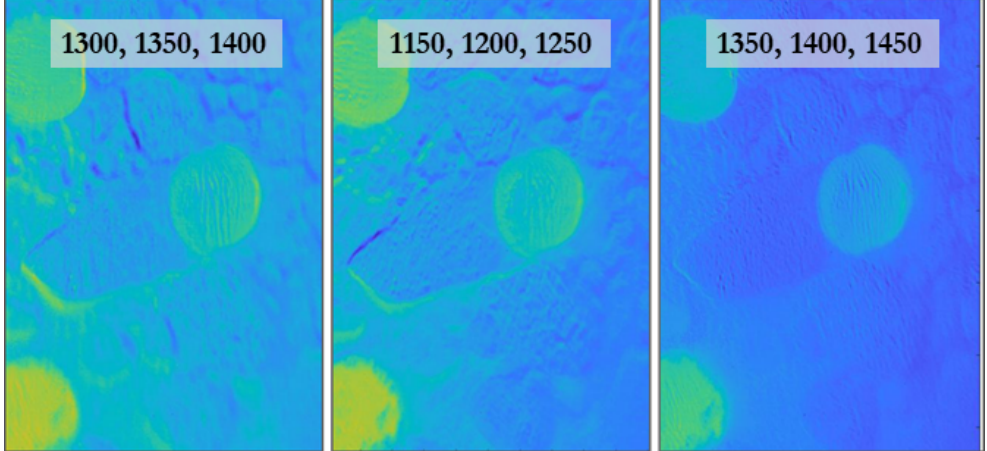
Figure 8. Each panel shows processed images of PP MP where the reflectance contrast at SWIR active wavelengths is drawn from neighboring wavelengths where absorption is lower. The three wavelengths listed in a panel each correspond to a filter. The middle wavelength is the reflectance value that is compared to the other two using a modified band depth analysis [57]. For instance, the middle panel shows reflectance strength at the key 1200 nm wavelength as contrasted to that of neighboring 1150 nm and 1250 nm wavelengths. The green-yellow color indicates a stronger absorption feature (lower reflectance) while the blue indicates a lack of feature